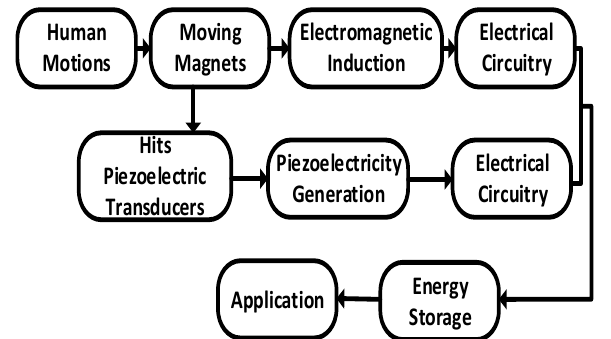
Figure 1:Functional block diagram of the energy harvesting device